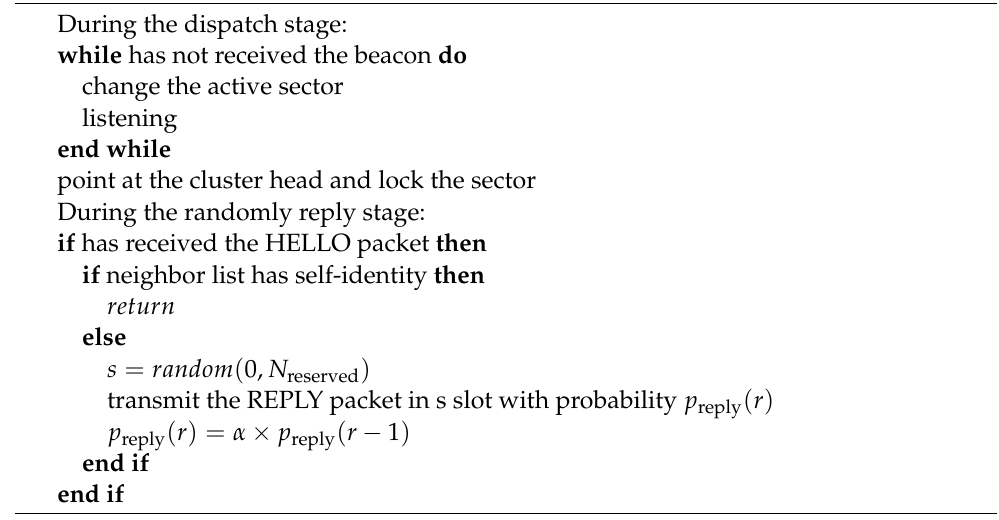
Algorithm 2 Random reply algorithm in cluster member